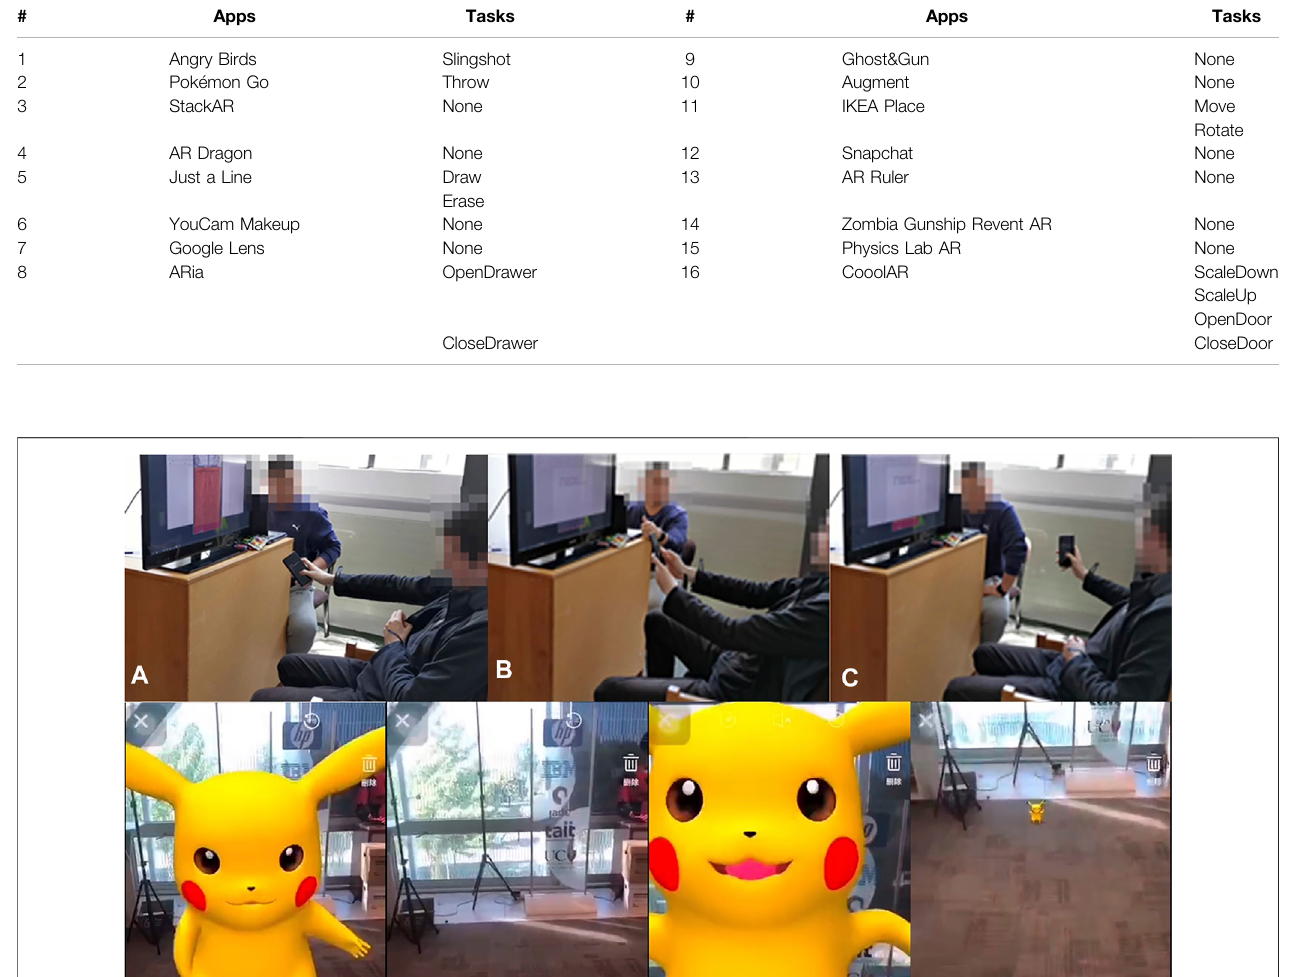
Frontiers in Virtual Reality |